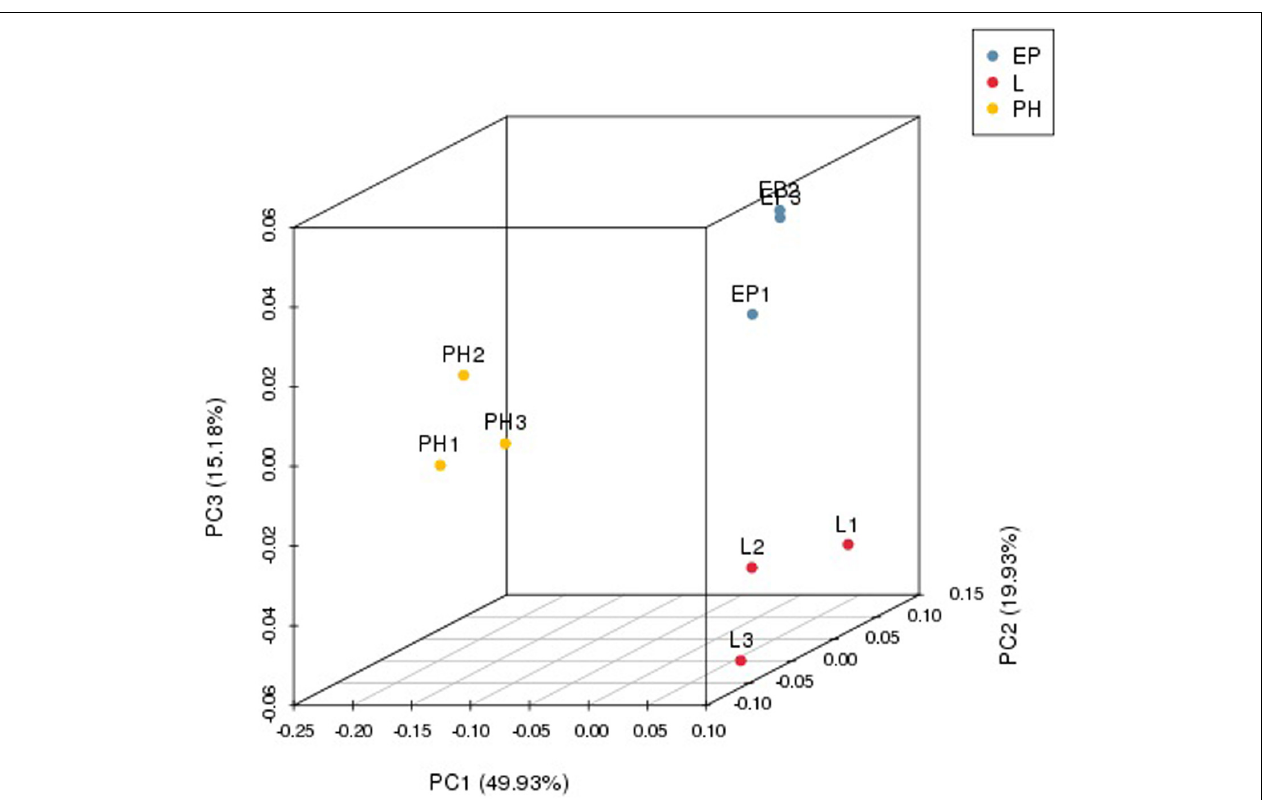
FIGURE 2 | Principal component analysis (PCA) for the embryo samples.